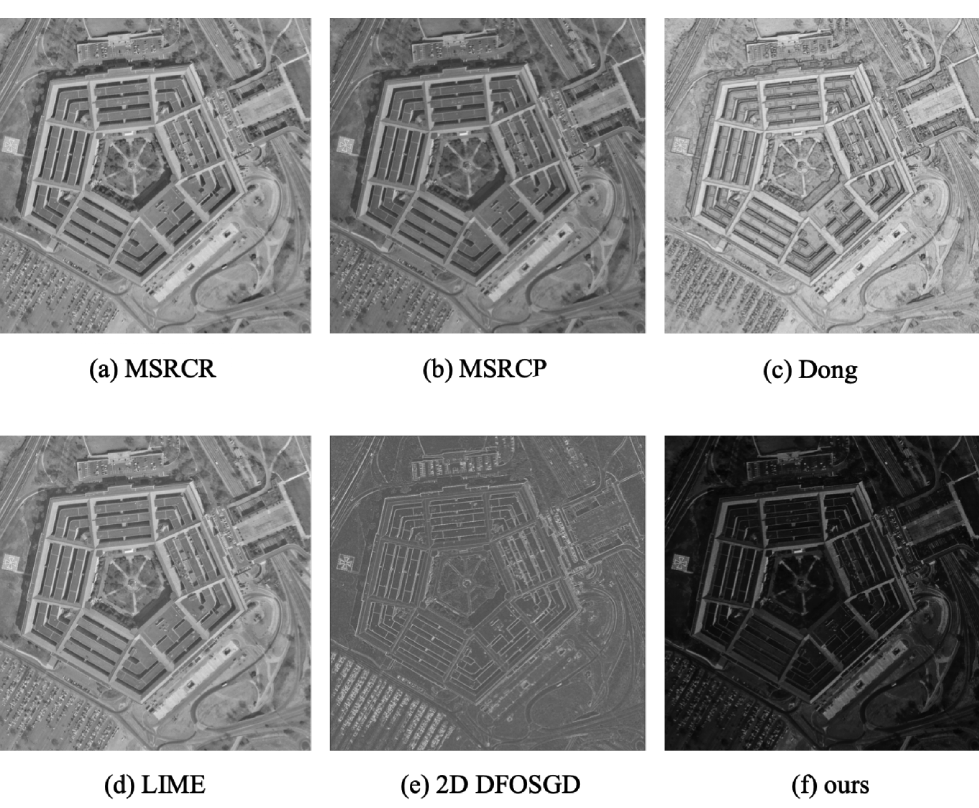
Figure 16. The comparison of the enhancement